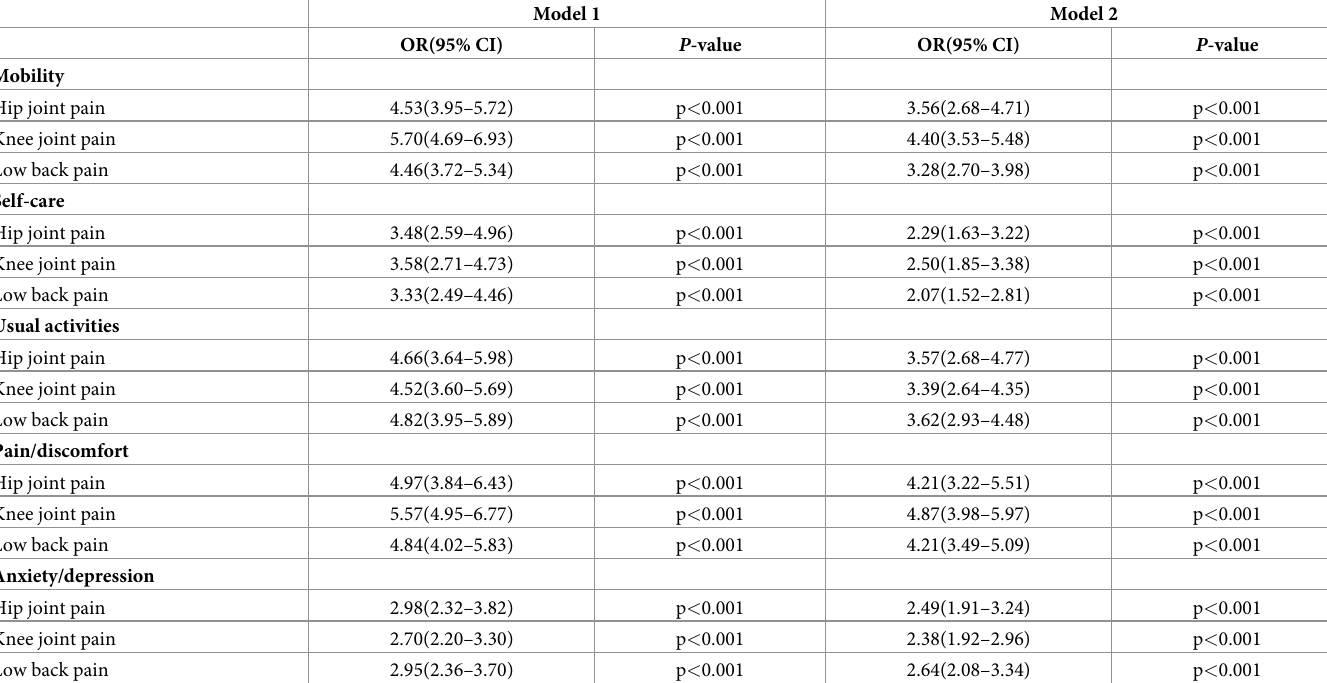
Table 5. Association between quality of life and OA pain site using multiple logistic regression analysis by